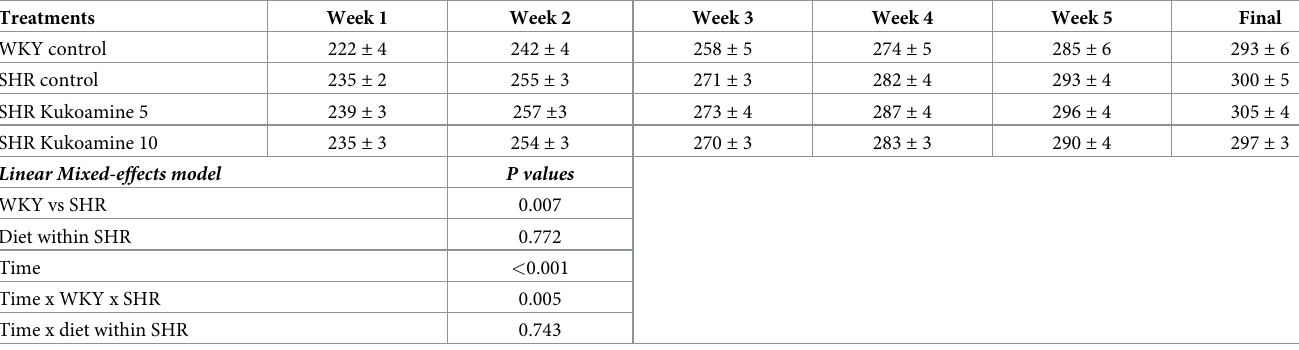
Table 1. Weekly mean body weights (g) of the rats on the experimental treatments 1 .